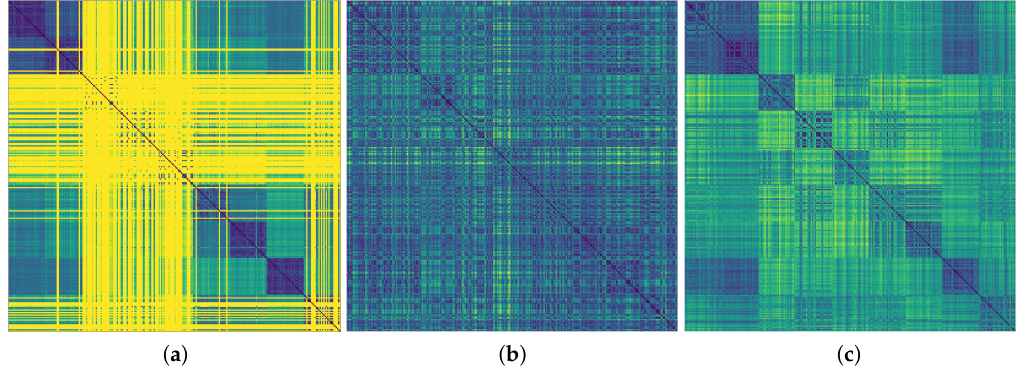
Figure 33. Distance matrices (between all pairs of the training images, darker is lower, yellow means wrong joint detection); ( a ) SRHandNet, ( b ) MediaPipe, ( c )